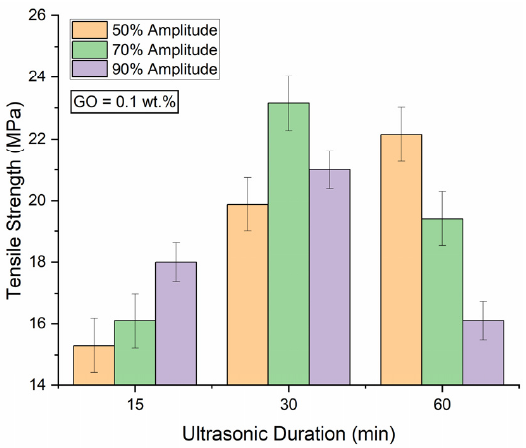
Figure 7. Tensile strength of 3D ‐ printed nanocomposite at varying amplitudes and